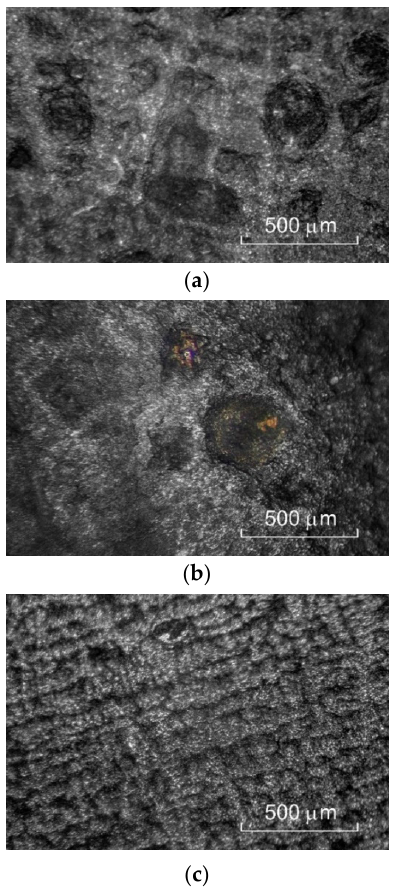
Figure 20. View of the sample surface once the critical machining states occurred: ( a ) cavitation, ( b ) single short circuit, ( c ) wave structure.